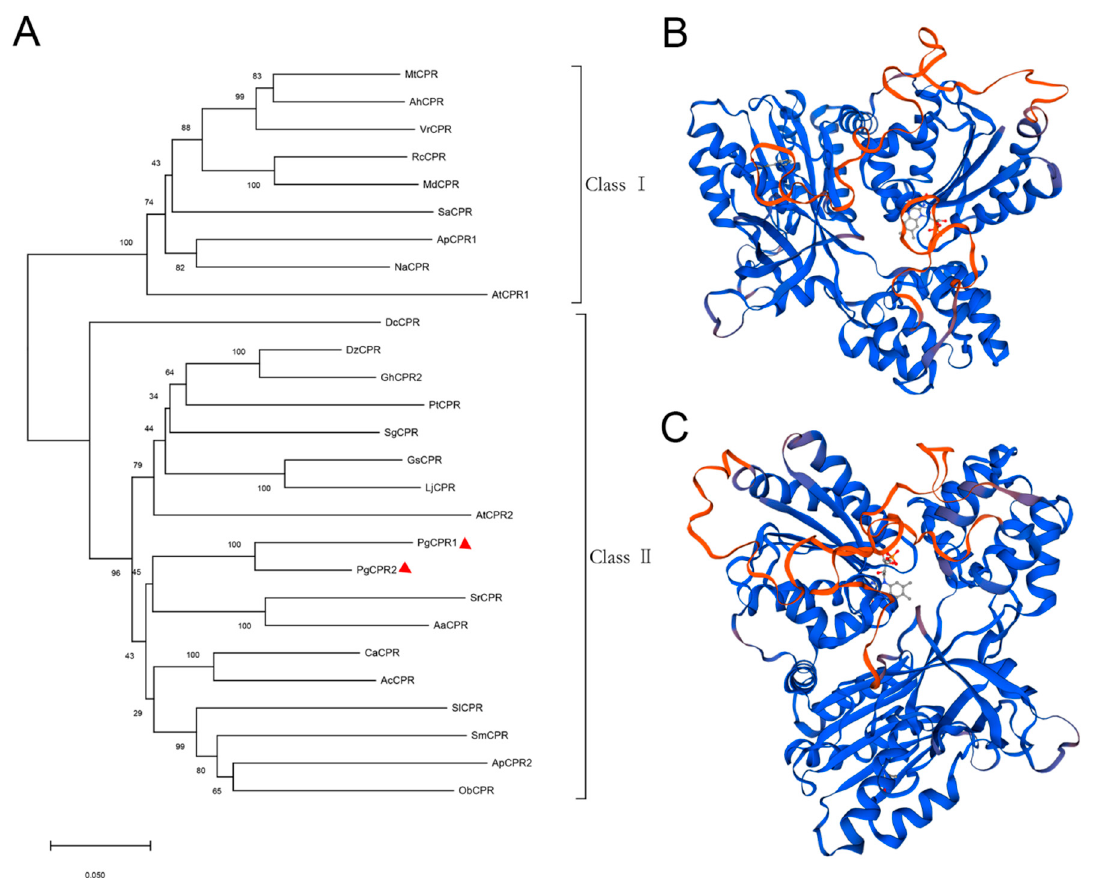
Figure 2. Phylogenetic analysis of PgCPRs. ( A ) The phylogenetic tree was constructed by the neighbor-joining method of MEGA 7.0, and 27 amino acid sequences of CPR protein were analyzed, which come from the following plant species: Arachis hypogaea (AhCPR: XP025668510), Artemisia annua (AaCPR: ABM88789), Actinidia Chinensis (AcCPR: PSS36215), Andrographis paniculate (ApCPR1: AQT38168, ApCPR2: AQT38169), Arabidopsis thaliana (AtCPR1: NP194183, AtCPR2: NP194750), Camptotheca acuminate (CaCPR: AJW67229), Dendrobium catenatum (DcCPR: PKU78870), Durio zibethinus (DzCPR: XP022729926), Gossypium hirsutum (GhCPR2: NP001314398), Glycine soja (GsCPR: KHN17598), Lotus japonicus